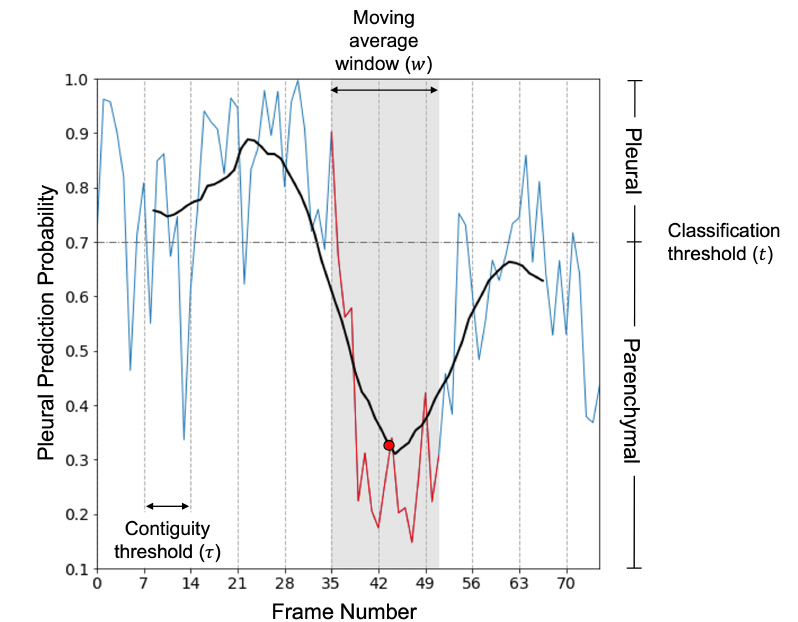
Figure 2. Visual representation of the clip prediction method. For each clip, the raw frame-level prediction probabilities outputted from the neural network (blue curve) are smoothed by computing a moving average (black curve): each point (red dot) on the smoothed prediction curve represents the average of a set of w consecutive frame-level prediction probabilities (red curve). The clip is predicted as pleural if τ contiguous smoothed predictions meet or exceed the classification threshold t , and parenchymal otherwise. A true positive (pleural) clip is shown, as predicted using the optimal hyperparameter set ( τ = 7, t = 0.7, w =